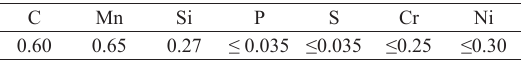
Table 2. The chemical composition of medium carbon steel